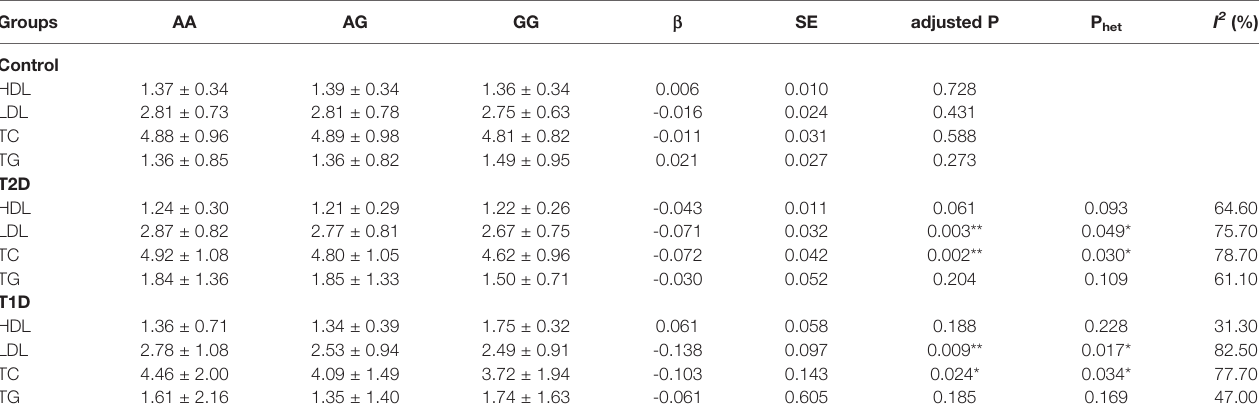
Linear regression analysis was used, with lipid index as the dependent variable and age, sex, lipids medication and BMI (type 1 not used) as independent variables. All P values were two- tailed and P < 0.05 was considered as signi fi cant. *P < 0.05; **P < 0.01. T2D, type 2 diabetes; T1D, type 1 diabetes; HDL, high-density lipoprotein; LDL, low-density lipoprotein; TC, total cholesterol; TG, triglyceride.